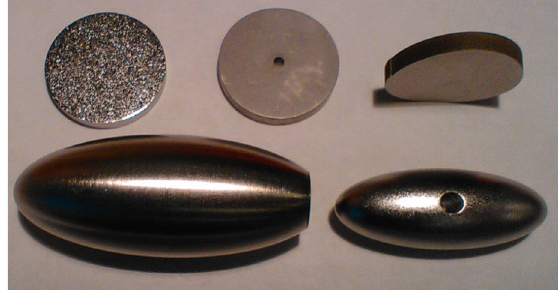
FIG. 8. Example of samples used in the experiment. Top, from left to right: Coins after BCP, after deposition of Nb3Sn (the whole in the middle was used to hang the sample in the furnace) and cut from a 1.3 GHz cavity half cell. Bottom: Ellipsoids used in LAMPF (left) and HPF